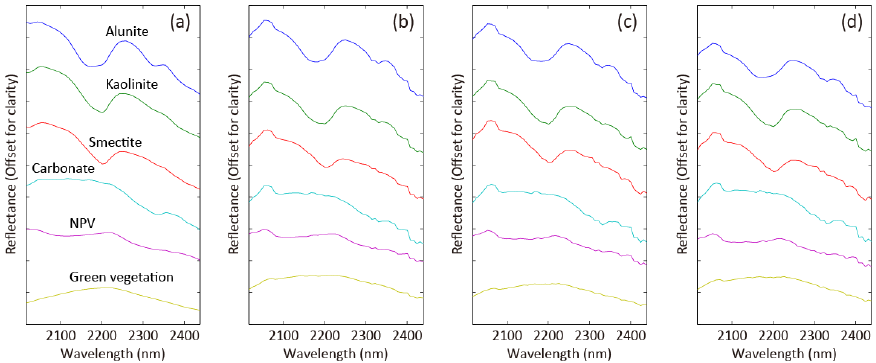
Figure 7. Endmember spectra derived from ( a ) reference; ( b ) CNMF; ( c ) GSA; and ( d ) bicubic interpolation data.